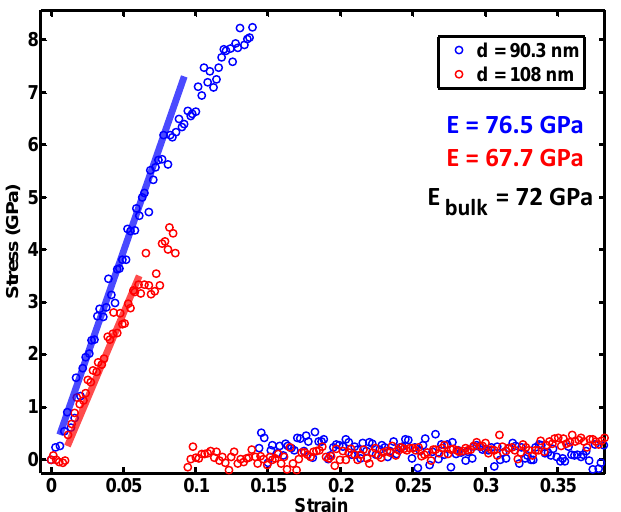
Figure 11. Stress–strain curves for the silica nanofibers.